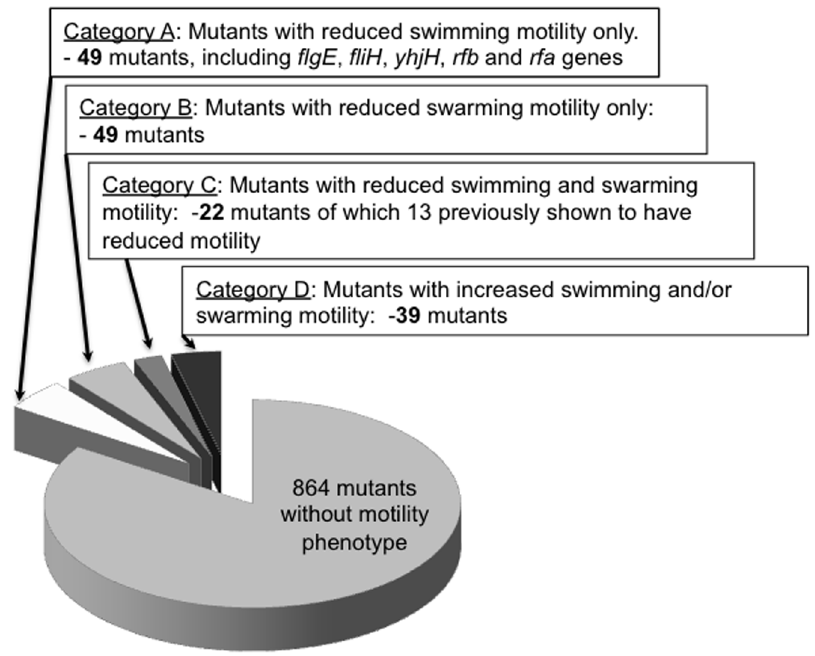
Figure 2. Distribution of motility phenotypes in single gene knock out collection.